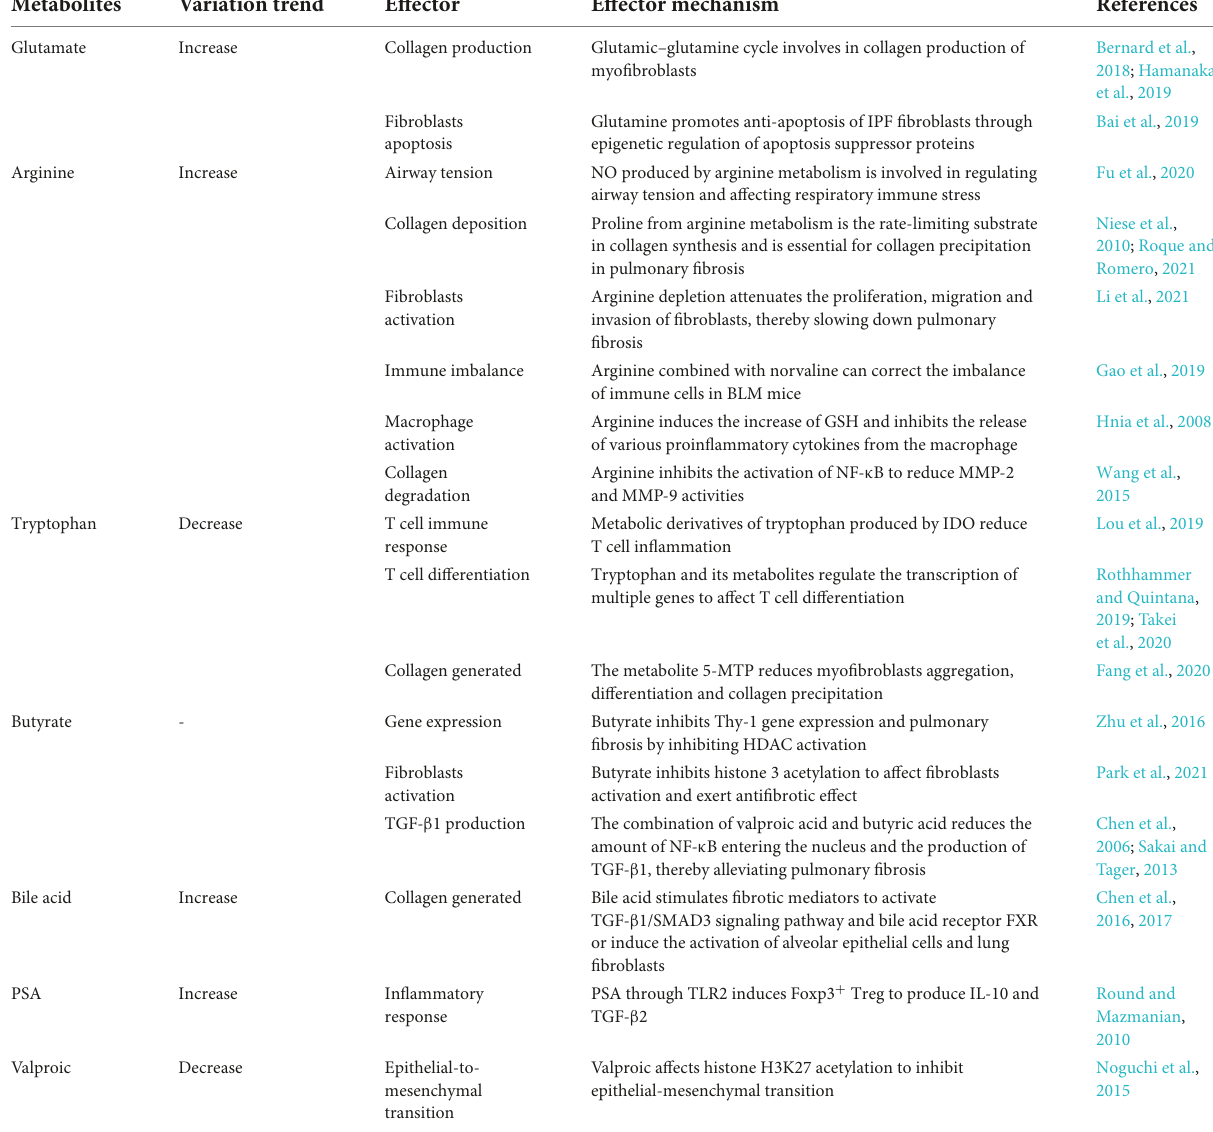
TABLE 2 Effects of gut microbiome metabolites in pulmonary